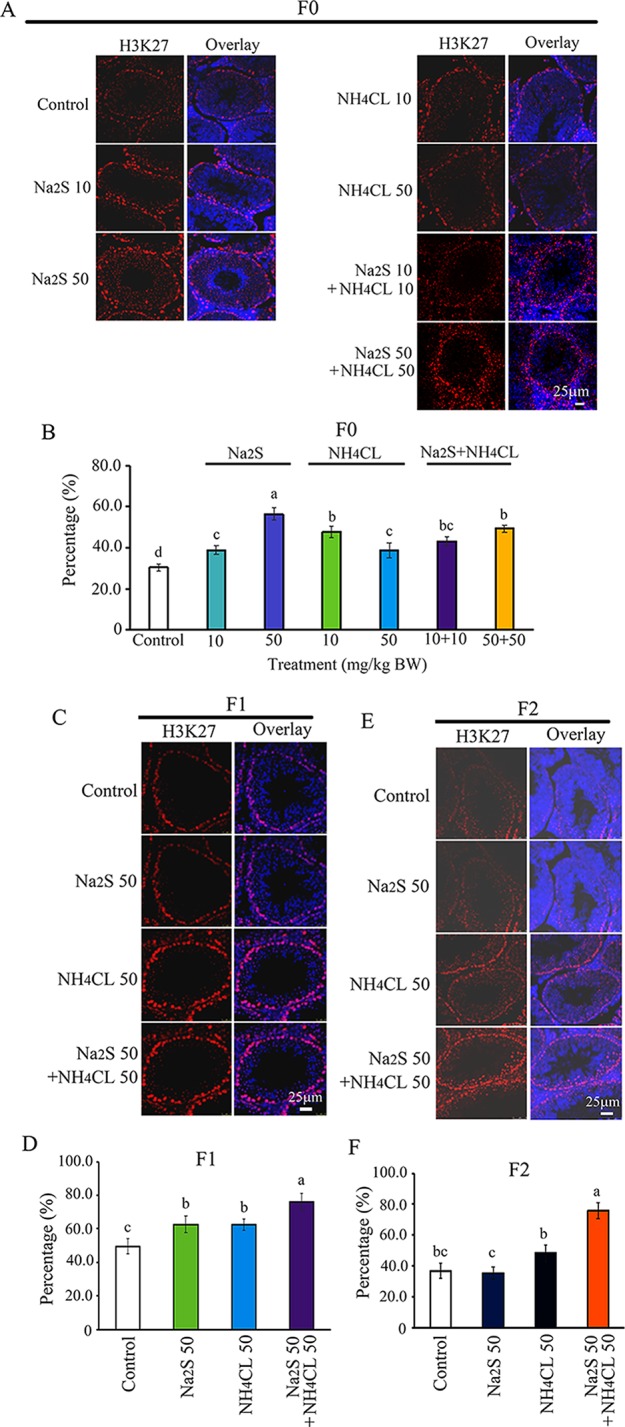
Protein H3K27 in mouse testicular tissue as detected by immunofluorescence staining. (A) H3K27 staining in F0 mouse testis. (B) Quantitative data for H3K27 in F0 mouse testis. (C) H3K27 staining in F1 mouse testis. (D) Quantitative data for H3K27 in F1 mouse testis. (E) H3K27 staining in F2 mouse testis. (F) Quantitative data for H3K27 in F2 mouse testis. N > 6. a, b, c indicate a significant difference among different treatments (p < 0.05).